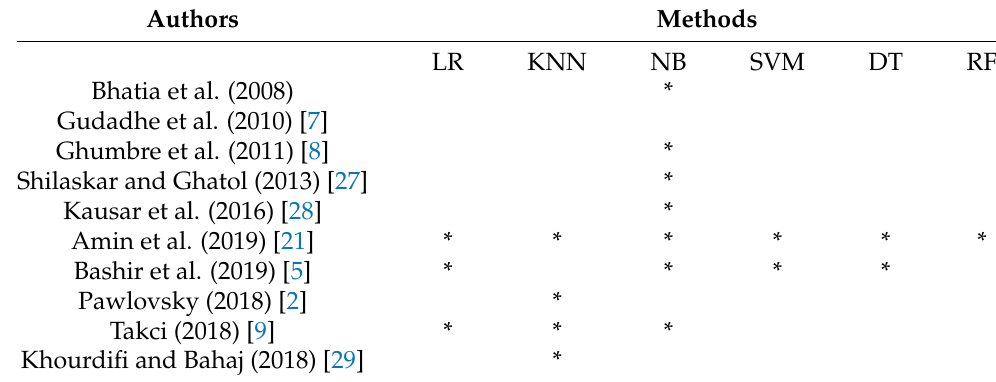
Table 1. Comparison with previous studies. An asterisk indicates that such methods are involved in the literature.